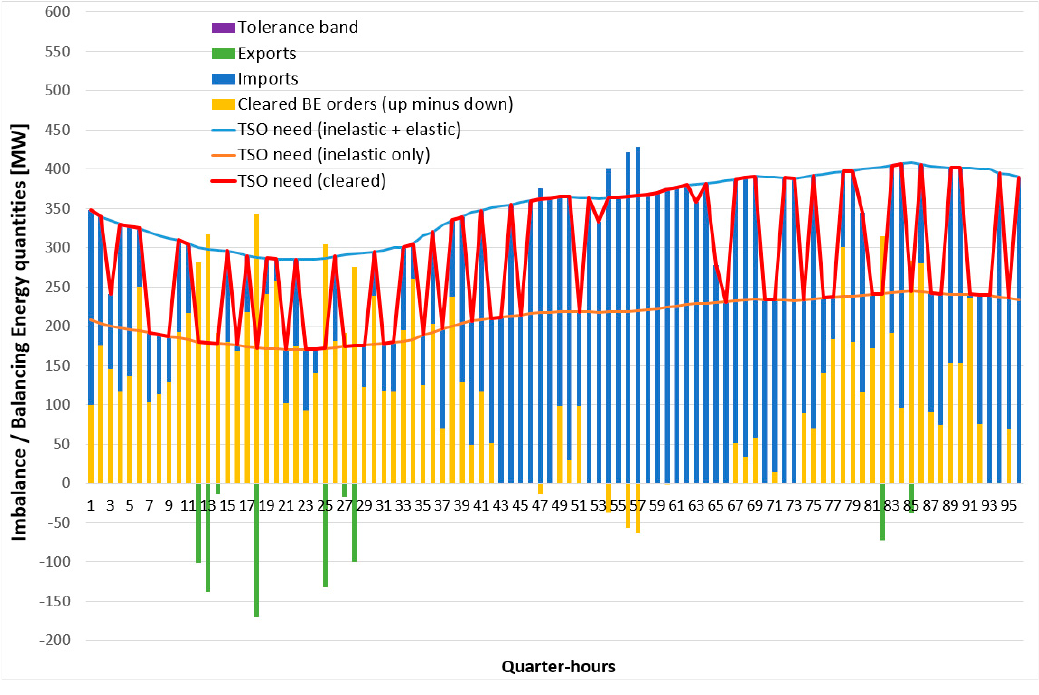
Figure 11. Clearing results per Real-Time Unit (RTU) for Portugal.